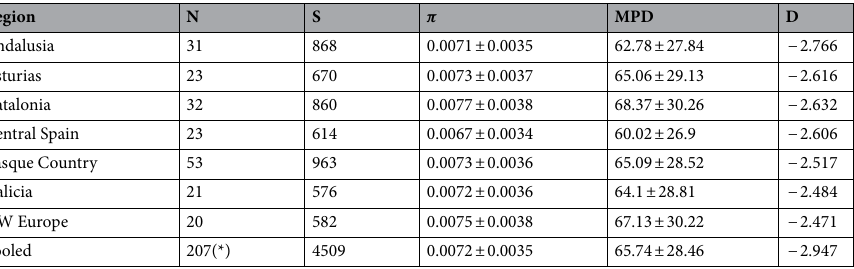
Table 3. Measures of diversity in R1b-DF27 chromosome sequences. S: number of SNPs; π : nucleotide diversity (× 1000); MPD: mean nucleotide pairwise differences; D, Tajima’s D (all tests with p < 0.0001). (*): the total sample size also includes four individuals from two populations (three individuals from Aragón